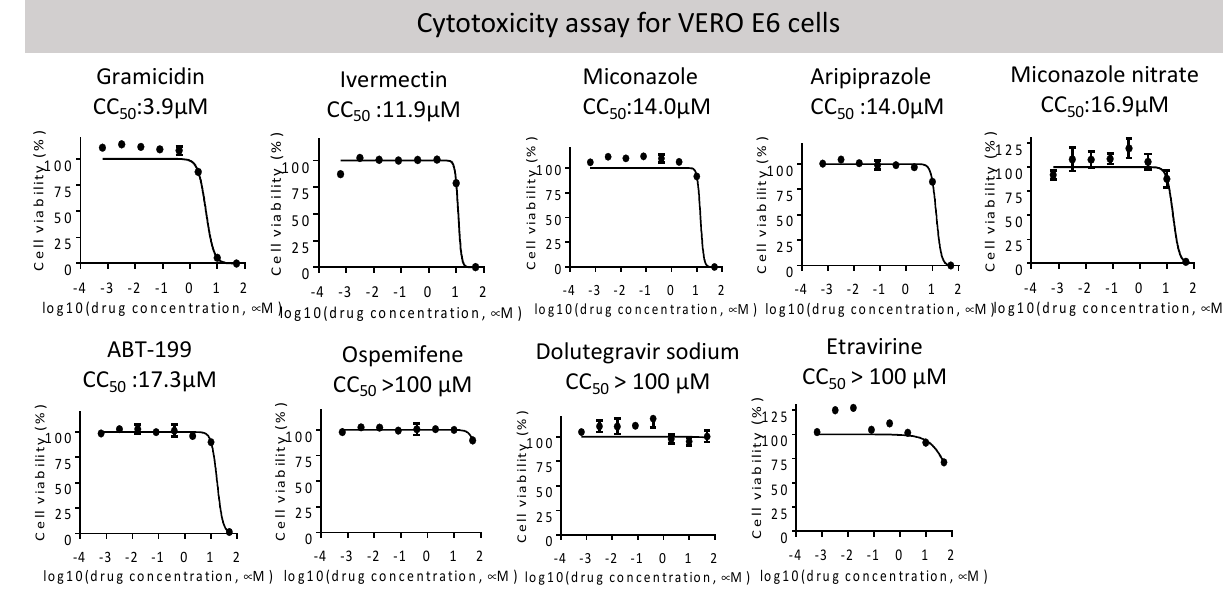
Figure 2. Overall cytotoxicity of indicated entry inhibitors was measured in VERO E6 cells by the CellTiter-Glo assay. CC50 values of each candidate are shown and listed in Table 2.